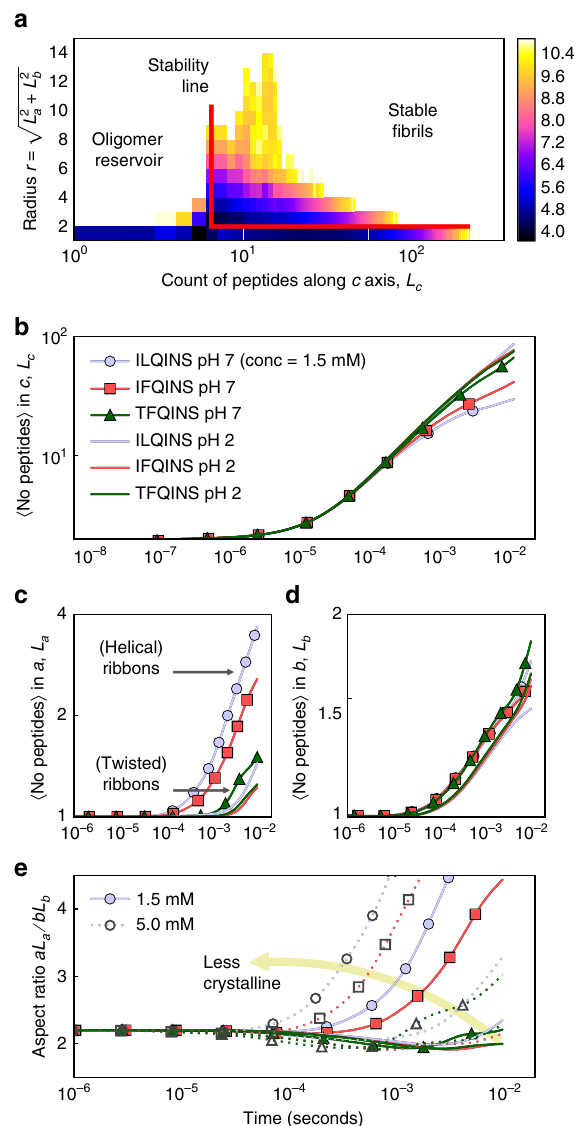
Fig. 4 Evolution of oligomer formation along axial ( c ) and lateral ( a , b ) assembly axes. a Two-dimensional histogram of length-radius distribution for TFQINS peptide aggregates at pH 2 after 0.5 ms. Lateral aggregates are not stable below a barrier length of L c = 6 peptides. b Plot of axial aggregation against time showing that ILQINS and IFQINS slow their axial aggregation. c Plot of lateral aggregation in a versus assembly time, and d plot of lateral aggregation in b versus assembly time. Aggregation in a takes off sharply at about 1 ms while lateral aggregation in b starts at 0.1 ms